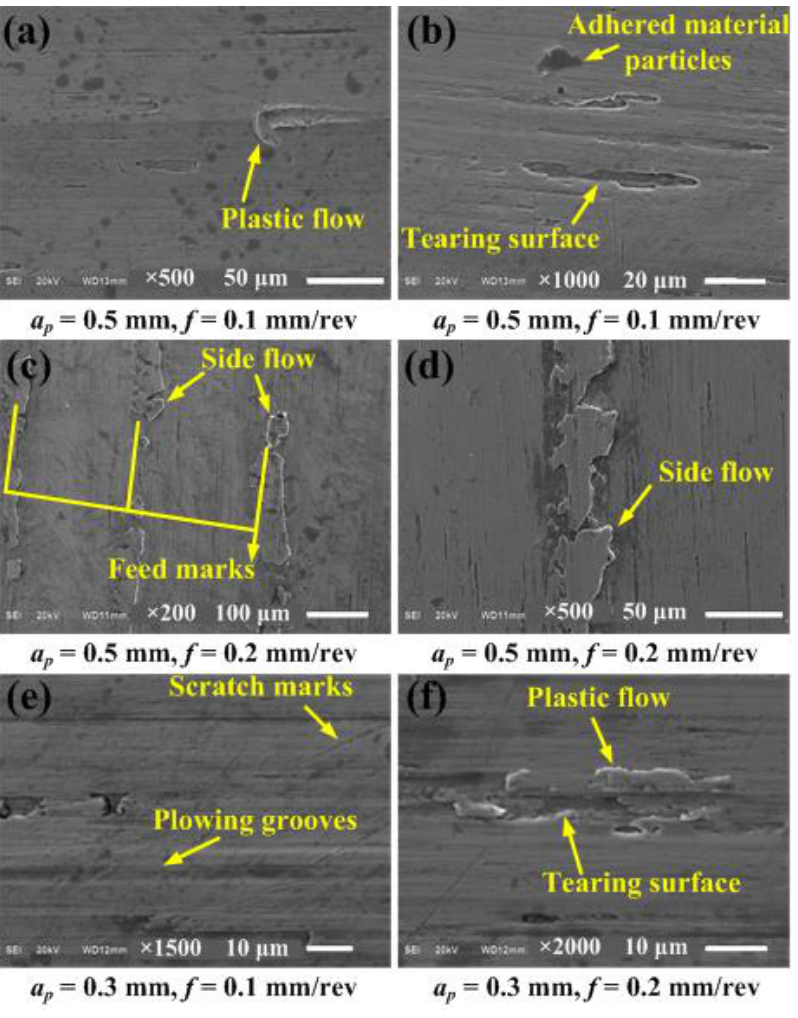
Figure 5. Surface defects of turned face surfaces, ( a ) a p = 0.5 mm, f = 0.1 mm/rev; ( b ) a p = 0.5 mm, f = 0.1 mm/rev; ( c ) a p = 0.5 mm, f = 0.2 mm/rev; ( d ) a p = 0.5 mm, f = 0.2 mm/rev; ( e ) a p = 0.3 mm, f = 0.1 mm/rev; ( f ) a p = 0.3 mm, f = 0.2 mm/rev.